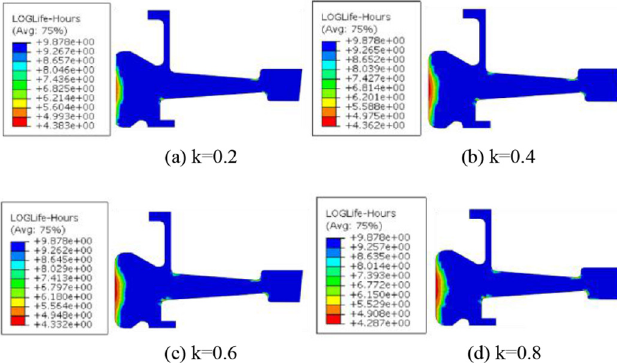
Fig. 16. Distribution diagram of logarithmic fatigue life of turbine disk with different values of parameter k: (a) k = 0.2, (b) k = 0.4, (c) k = 0.6, and (d) k = 0.8.